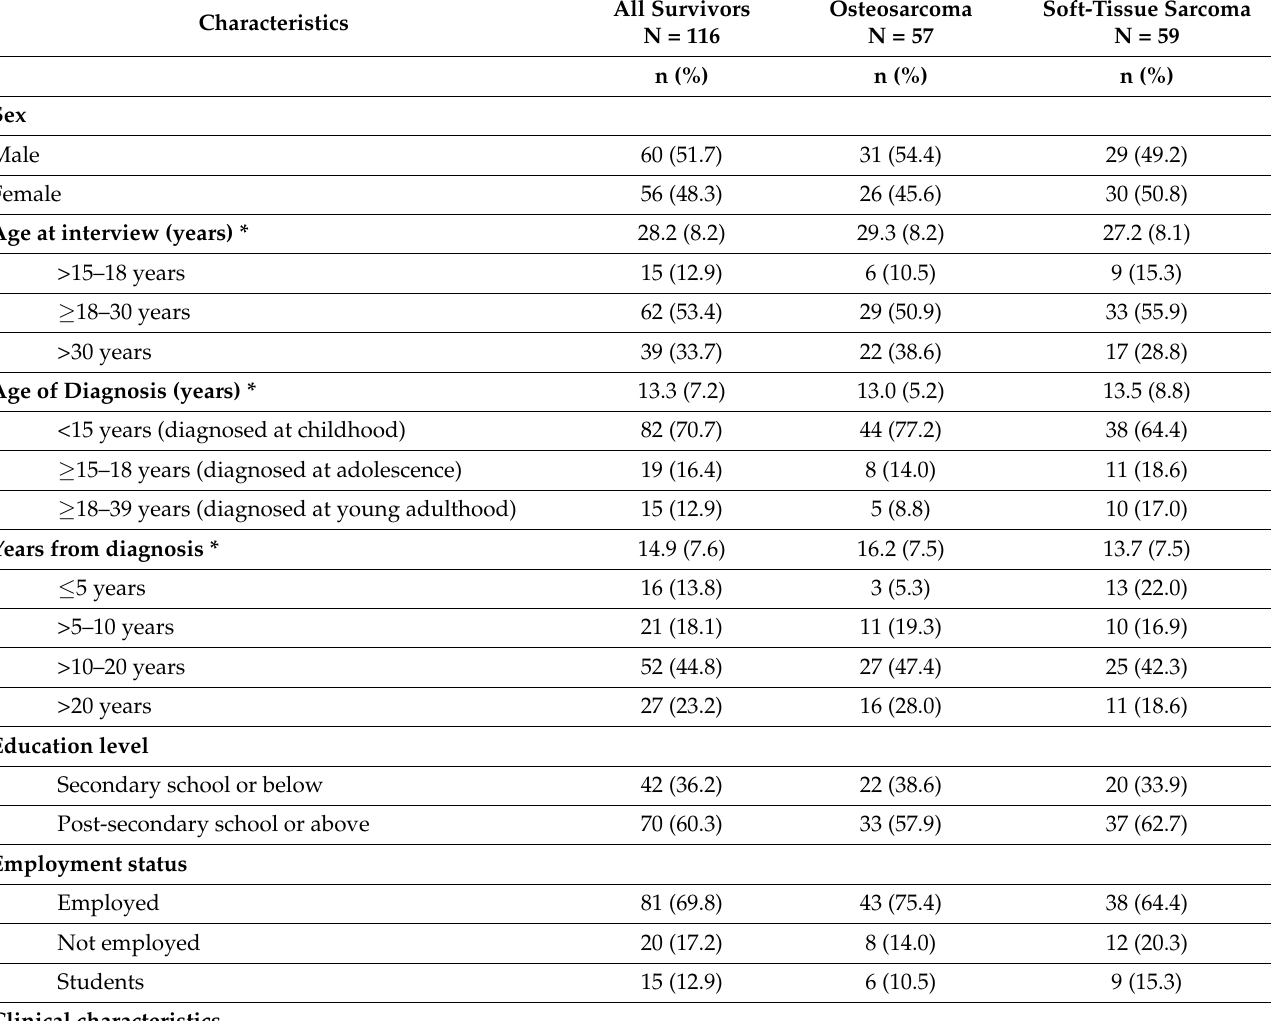
Table 1. Characteristics of study